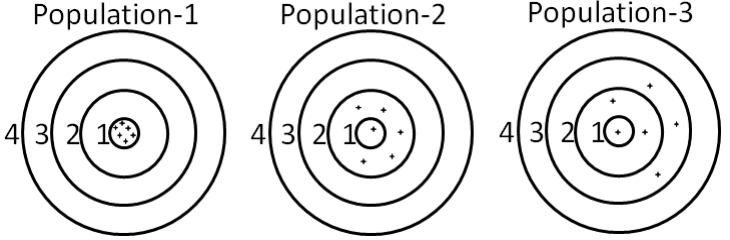
Fig. 3. Concentric rings representing possible variations of the reference ranges of indicative parameters in the diseased-individuals. Here, the situation with three hypothetical populations with six representative diseased-individuals in each sketch is illustrated. The dots' positions represent the parameter-values' variation among the diseased-individuals of the respective population. Four possible ranges that could be set as the reference range-limits of the test are de¯ned; wherein range-3 and range-4 are the widest and they cover the possible variations in all the three populations. A test with such a large range as range-4 would sort all the diseased-cases as diseased, but it would also sort non-diseased ones as diseased. Therefore, it is aimed in case of such tests to set the range as narrow as possible so that the whole values that belong to the diseased-individuals would be covered and hence identi¯ed as disease-indicative while those that belong to the non-diseased ones are excluded. Range-1, which would be set to indicate diseased-state according to population-1 in an optimal manner, will be missing many diseased-individuals in both population-2 and population-3. Range-2, which would be set to indicate diseased-state according to popu- lation-2 in an optimal manner, will be missing diseased-individuals in population-3, and would have the risk of identifying non-diseased ones as diseased in population-1. Range-3, which would be set to indicate diseased-state according to population-3 in an optimal manner, would not be missing any diseased- individuals in any of the populations but would have the risk of identifying non-diseased people as diseased in both population-1 and population-2. This hypothetical example exaggerates the likely scenarios for the sake of a better representation of the possible unintentional misleads, to highlight the importance of inter-population variations. By the term inter-population variation, it is meant that the possibility of varying reference (negative/positive or healthy/diseased) ranges among populations is present for at least some physiological parameters, among which there can be detection-targets of diagnostic